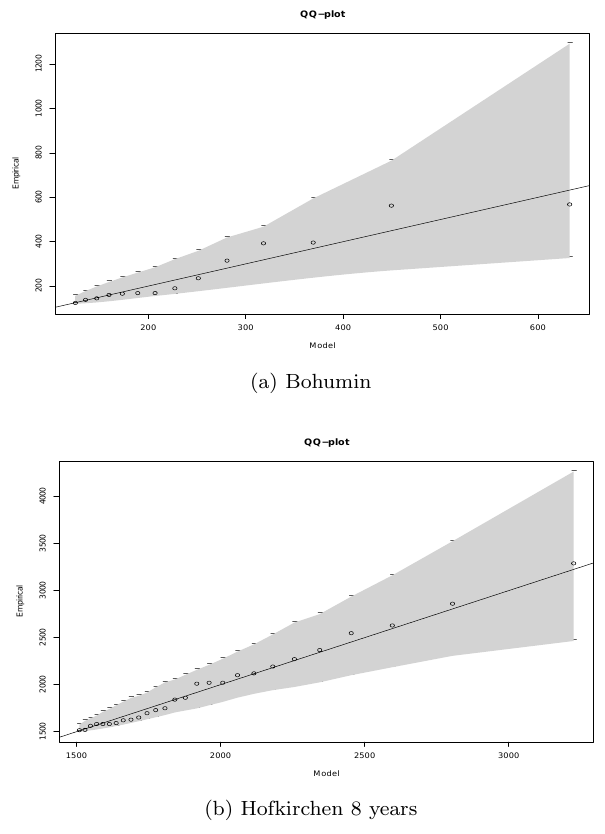
Fig. 4. Resulting QQ plot for the fitted extreme value distribu- tion (POT Model) versus empirical extreme values including the 95% confidence interval in gray for Bohumin (a) and Hofkirchen – 8yr (b)